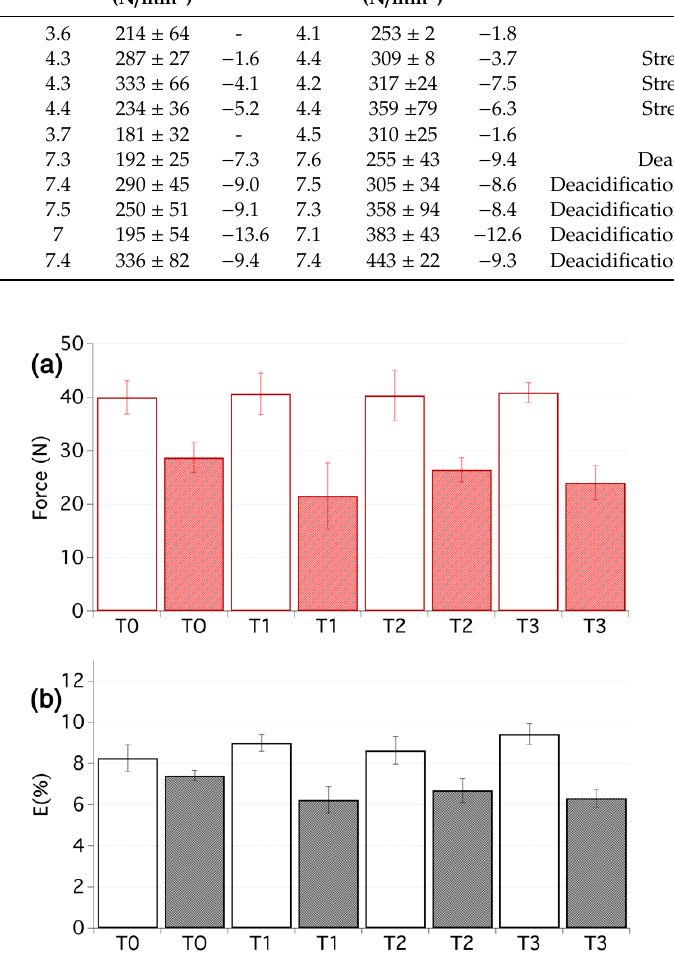
Figure 3. ( a ) Maximum force and ( b ) elongation at break for the first set of samples before ageing (empty bars) and after ageing (filled bars). From 5 to 10 tensile measurements per sample were carried out.